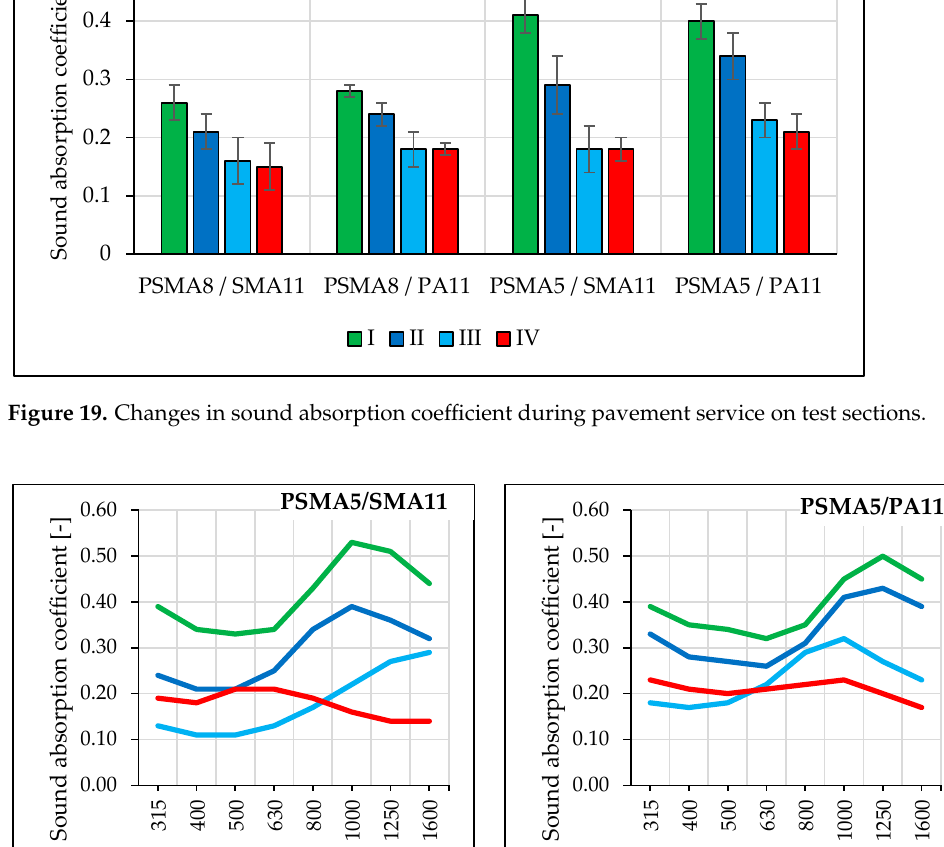
measurement periods on PSMA5/SMA11 and PSMA5/PA11 pavements.